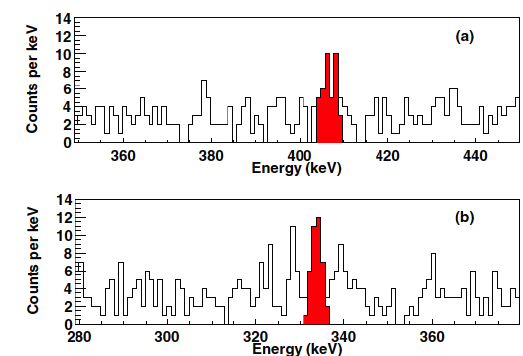
Figure 9. Coincidence plots collected in the experiment at Kimballton: ( a ) spectrum of events with energy around 406 keV in coincidence with a gamma of 334.0 keV; ( b ) spectrum of events with energy around 334 keV in coincidence with a gamma of 406.5 keV. Reprinted from Reference [31] with permission from American Physical